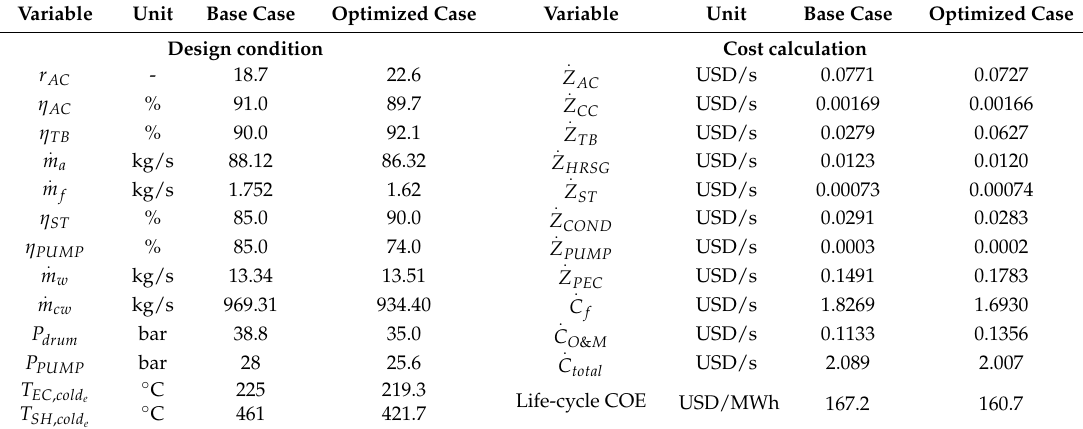
Table 10. Optimization results and relevant cost calculation for gas turbine